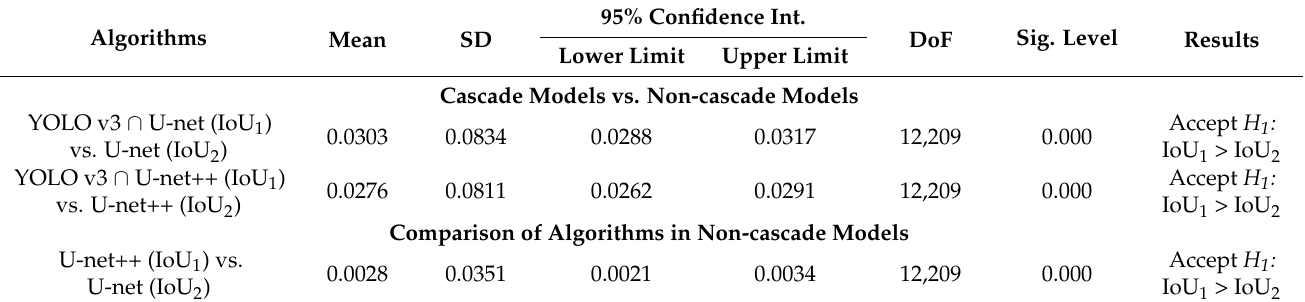
Table 3. Paired t -test of IoU ( α = 0.05) between the different cascade models and non-cascade